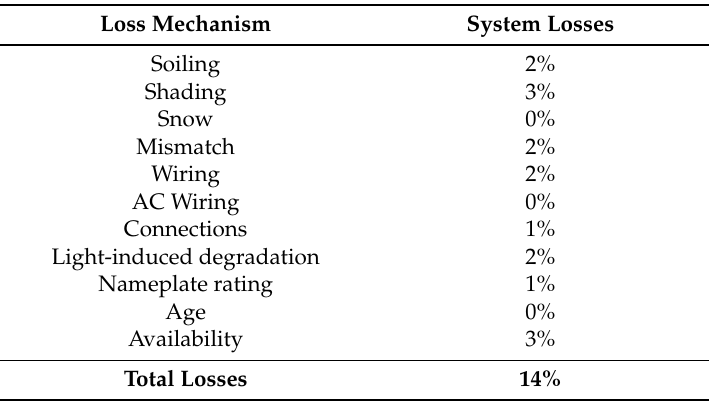
Figure 12. Selected neighborhood for the demonstration of distributed solar plant design. Table 1. System losses.